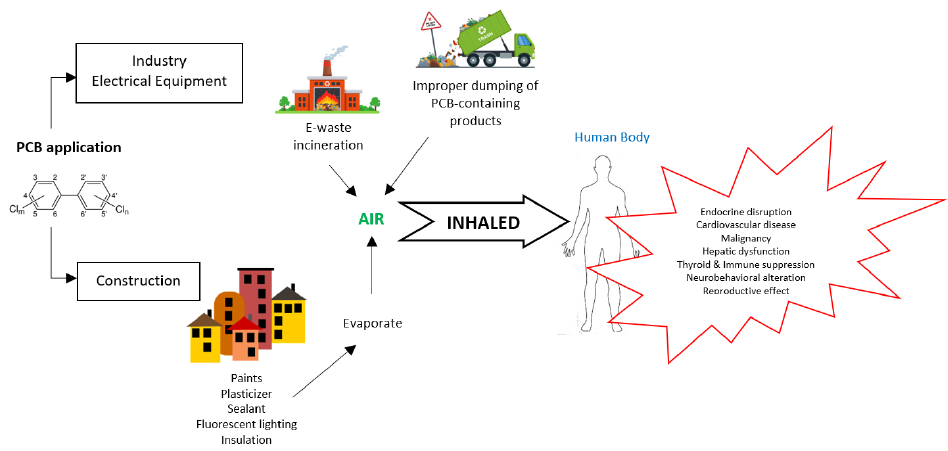
Figure 2. Sources of PCB in the air, human exposure, and possible health